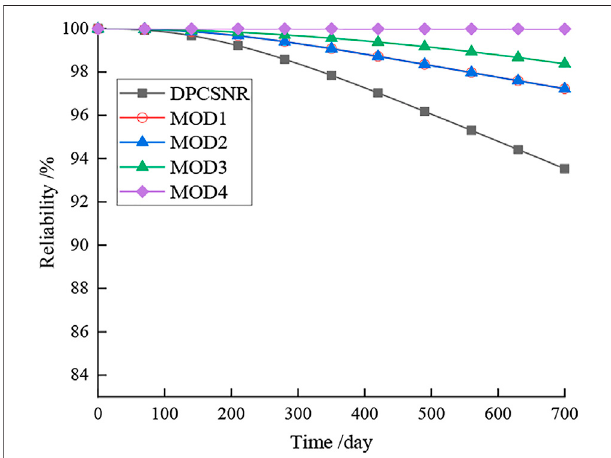
FIGURE 5 | Reliability curves for the DPCSNR and its four MODs.